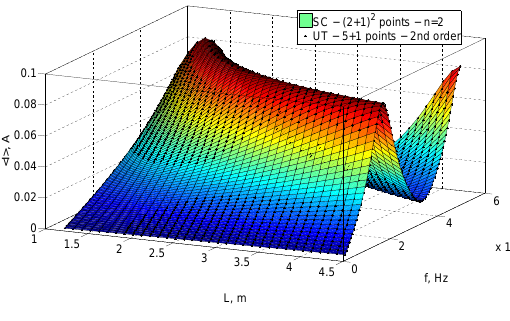
Figure 5: Mean( I ) from SC3 and UT5.